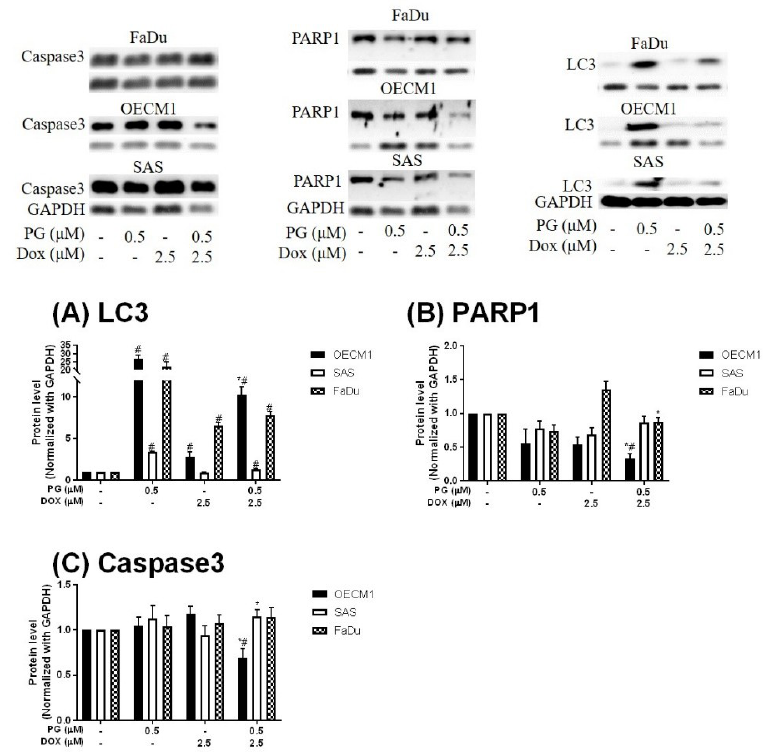
Figure 3. Expression of ( A ) LC3, ( B ) PARP1, and ( C ) Caspase3 in OSCCs after PG-priming. OSCC cells were treated with PG/Dox for 12/12 h and then desired protein levels were analyzed by Western blotting. The results were normalized with GAPDH and represented as mean ± SD from three individual experiments. Molecular weight: PARP1, 116 KDa; GAPDH, 37 KDa; Caspase3, 34 KDa; LC3, 18 KDa. # p < 0.05 compared with untreated control; * p < 0.05 as compared with Dox alone.